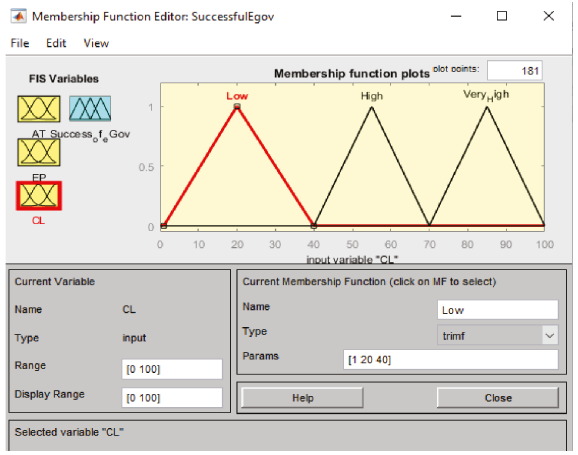
Figure 5: Fuzzification for